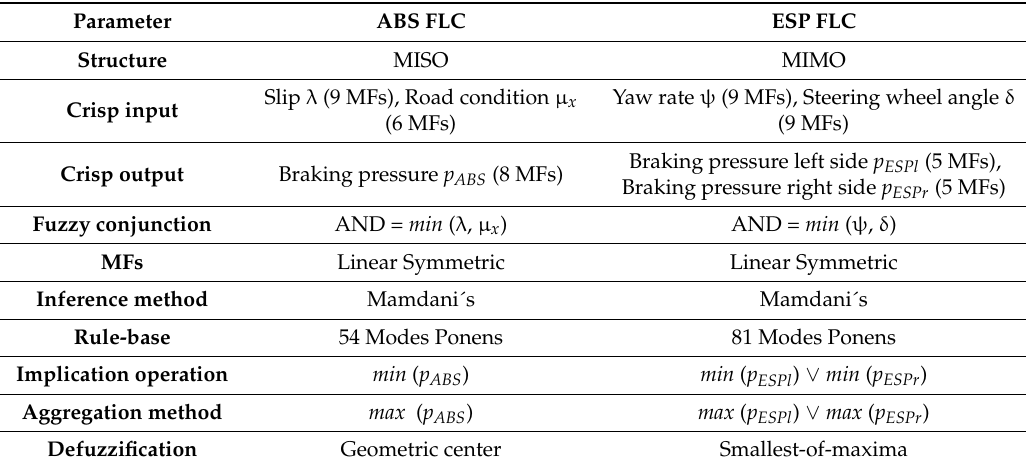
Figure 7. ESP FLC rule surface for the left side of the vehicle. Table 5. Fuzzy logic controller design conclusion.